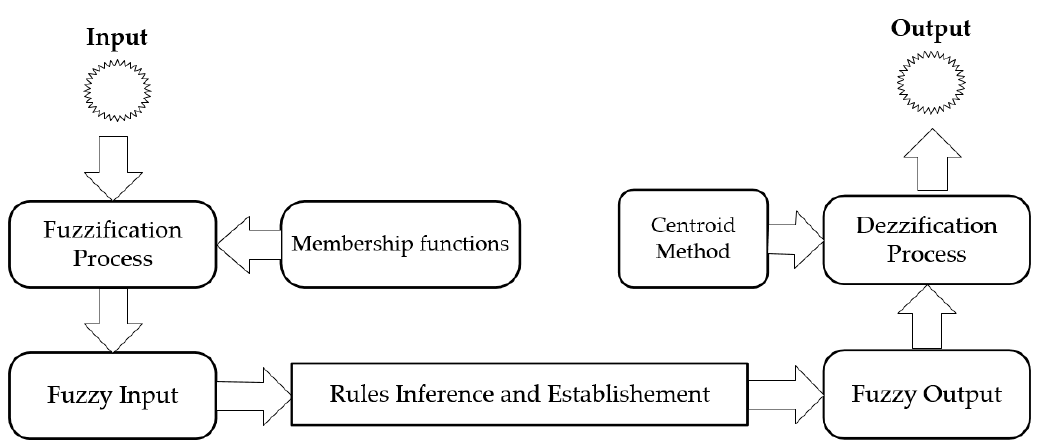
Figure 3. Structure diagram of the Mamdani fuzzy inference system.